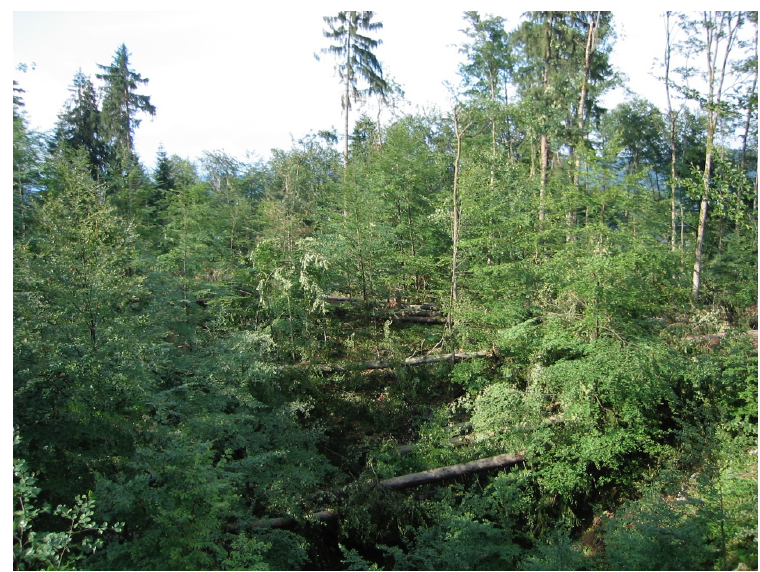
Figure 1. Uneven-aged managed forest stand in the Dinaric region of Slovenia immediately after a severe storm in 2004 that removed most of the canopy layer. The well-developed understory layer was largely undamaged, and serves an important role in forest recovery.